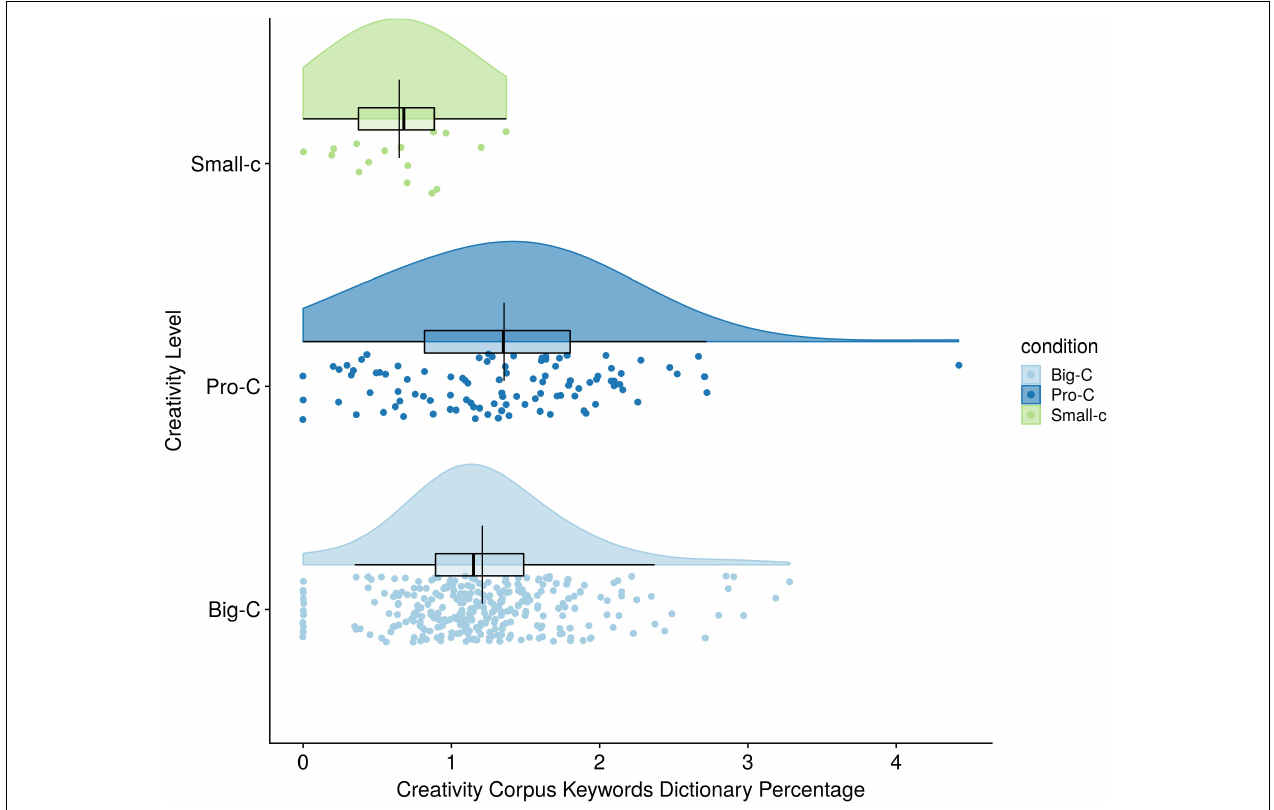
FIGURE 2 | Creativity level differences on creativity corpus keywords frequency